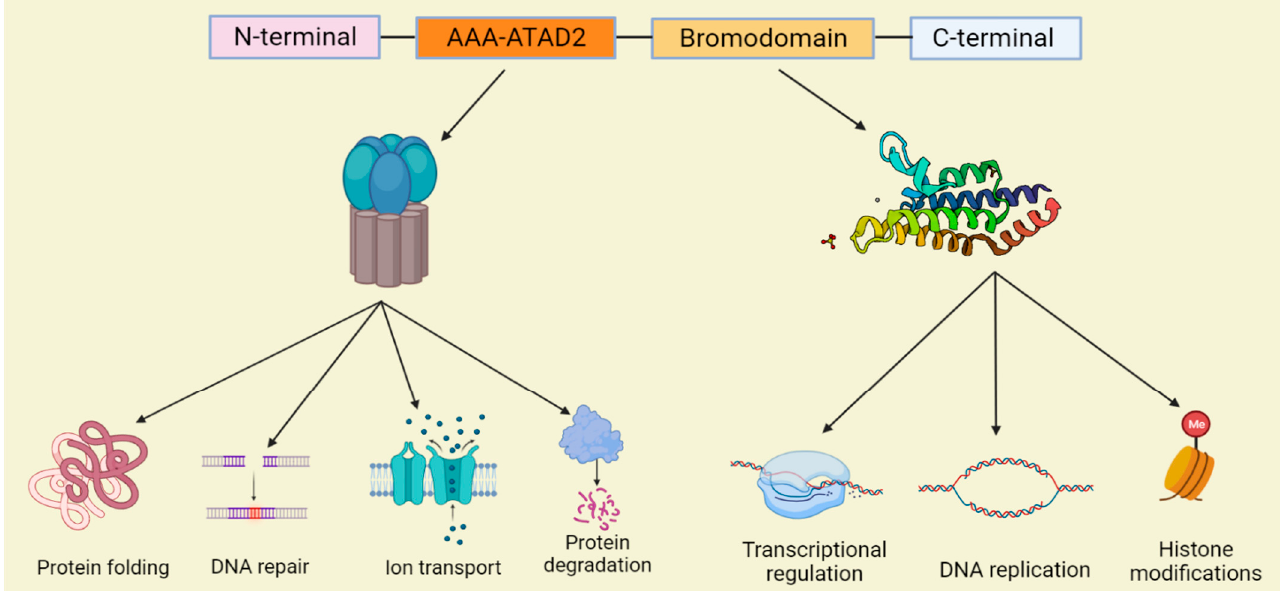
Figure 1. Schematic diagram of the ATAD2 domain structure and the partial functions of the AAA- ATAD2 and bromodomain. ATAD2 and